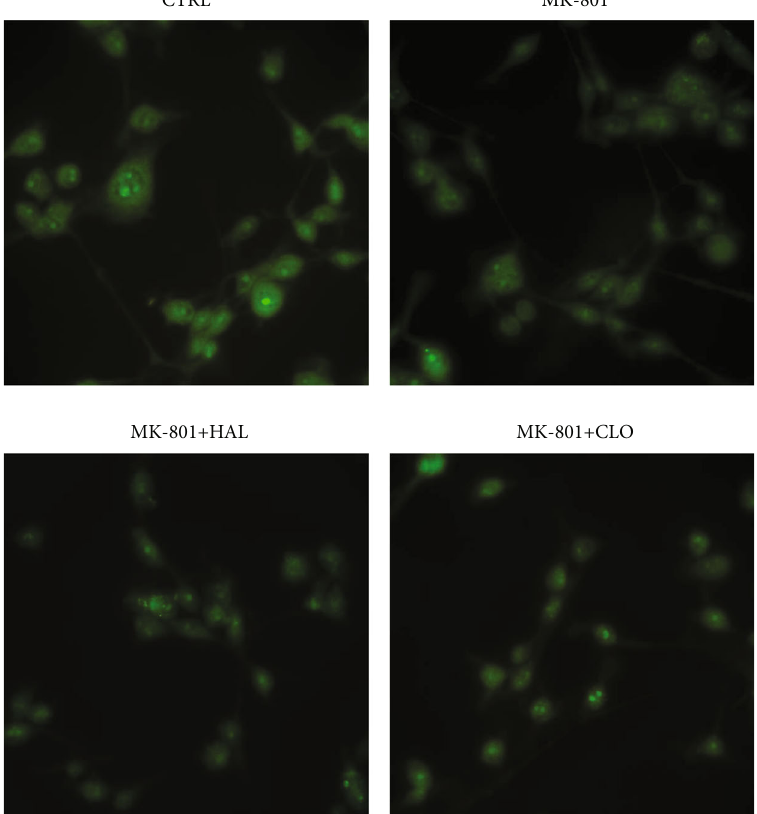
Figure 2: E ff ects of MK801, haloperidol, and clozapine on F-actin condensation in B35 cells. The B35 cells were treated with MK801 followed by haloperidol (HAL) or clozapine (CLO) treatment. CytoPainter Phalloidin-iFluor 488 Reagent was used to stain the F-actin of B35